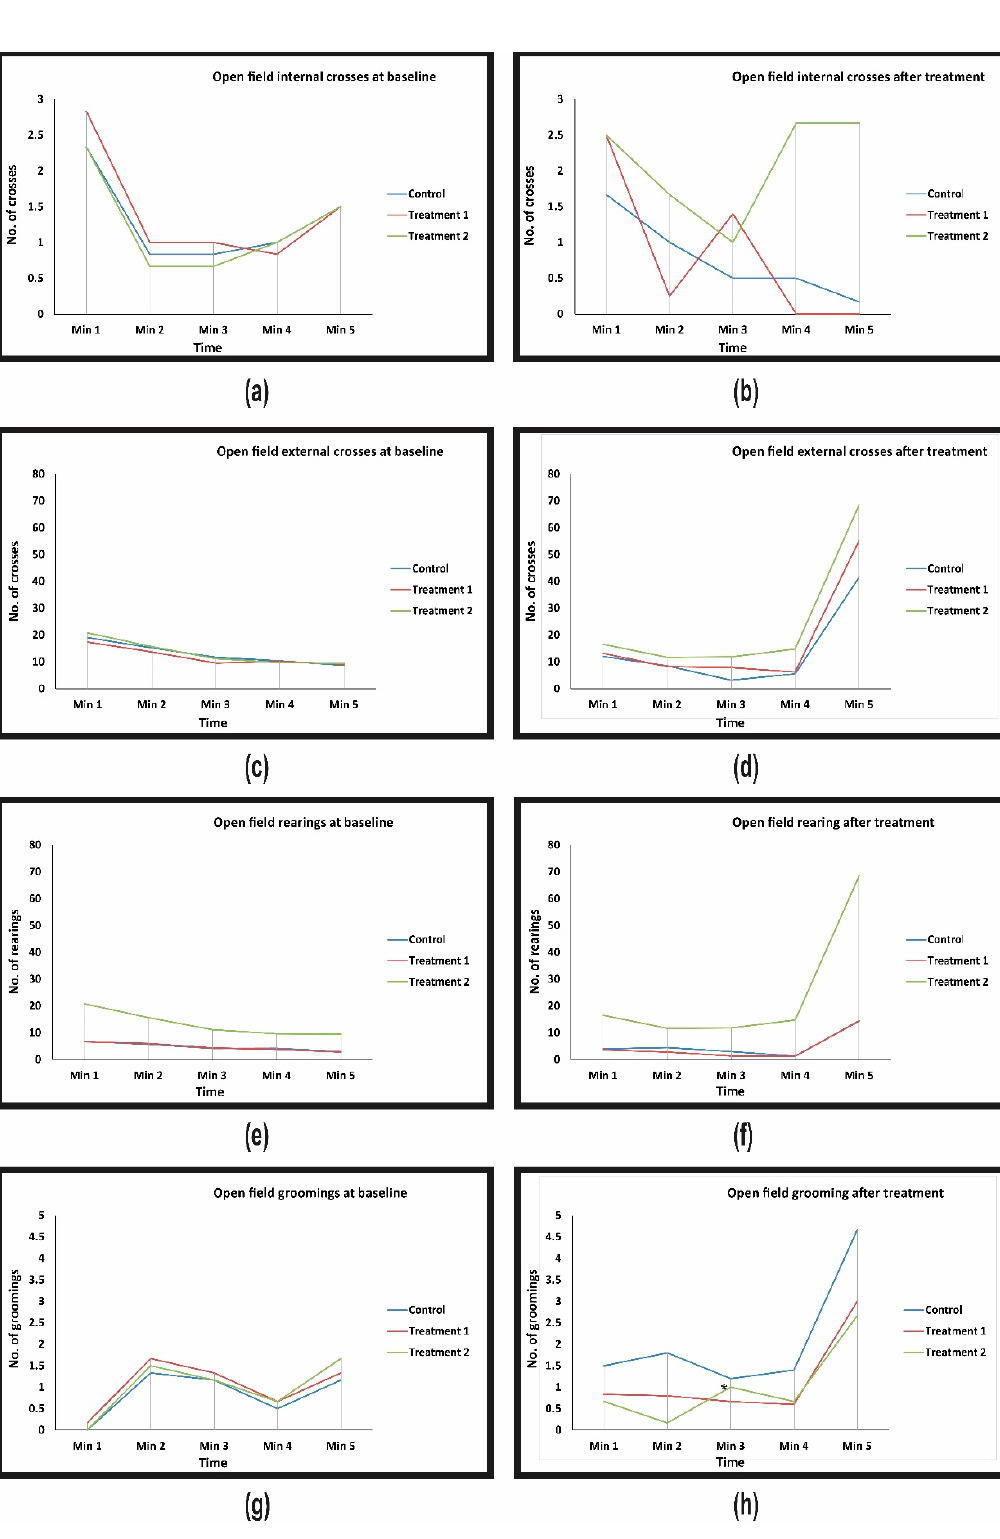
Figure 1. Timely evolution of open-field neurological tests conducted on control and treated rats. ( a ) The number of crossing over squares in internal regions at baseline; ( b ) The number of crossing over squares in internal regions after treatments; ( c ) The number of crossing over squares in external regions at baseline; ( d ) The number of crossing over squares in external regions after treatments; ( e ) Number of rearings at baseline; ( f ) Number of rearings after treatments; ( g ) Number of groomings at baseline; ( h ) Number of groomings after treatment. * Treatment effect is significant compared with the control group.